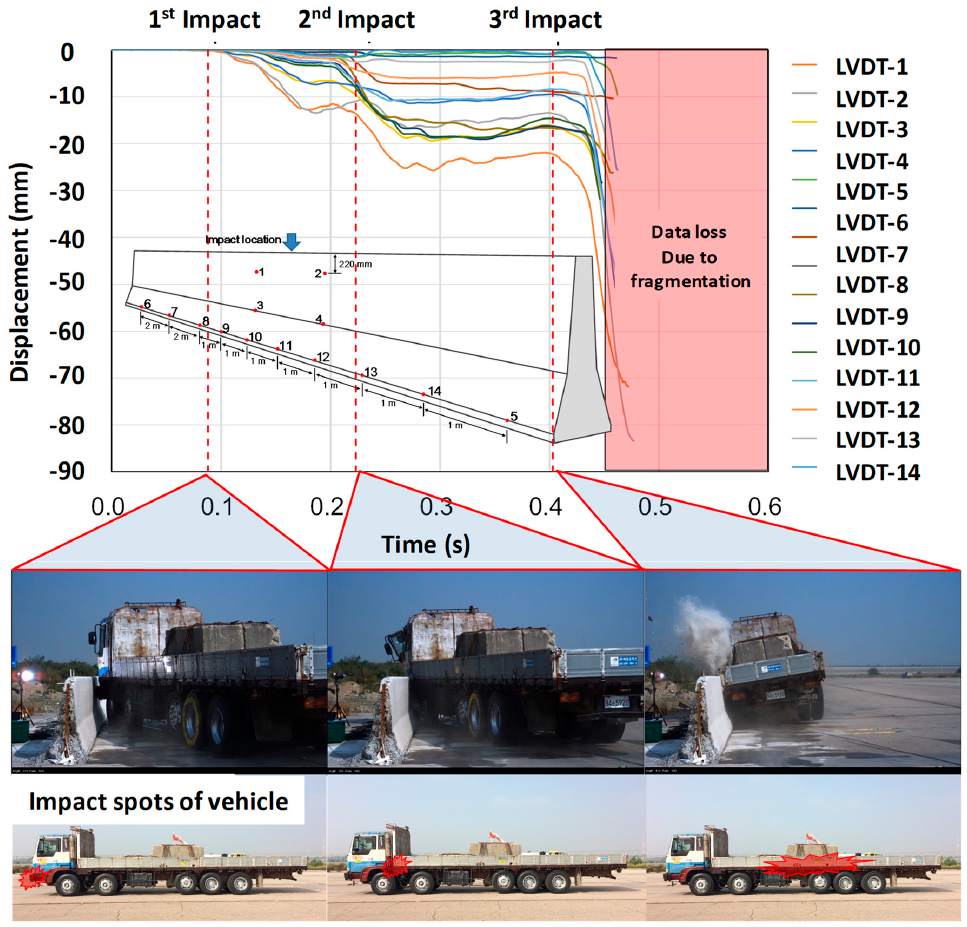
Figure 14. Obtained LVDTs’ data of concrete median barrier during impacts. Materials 2019 , 12 , x FOR PEER REVIEW